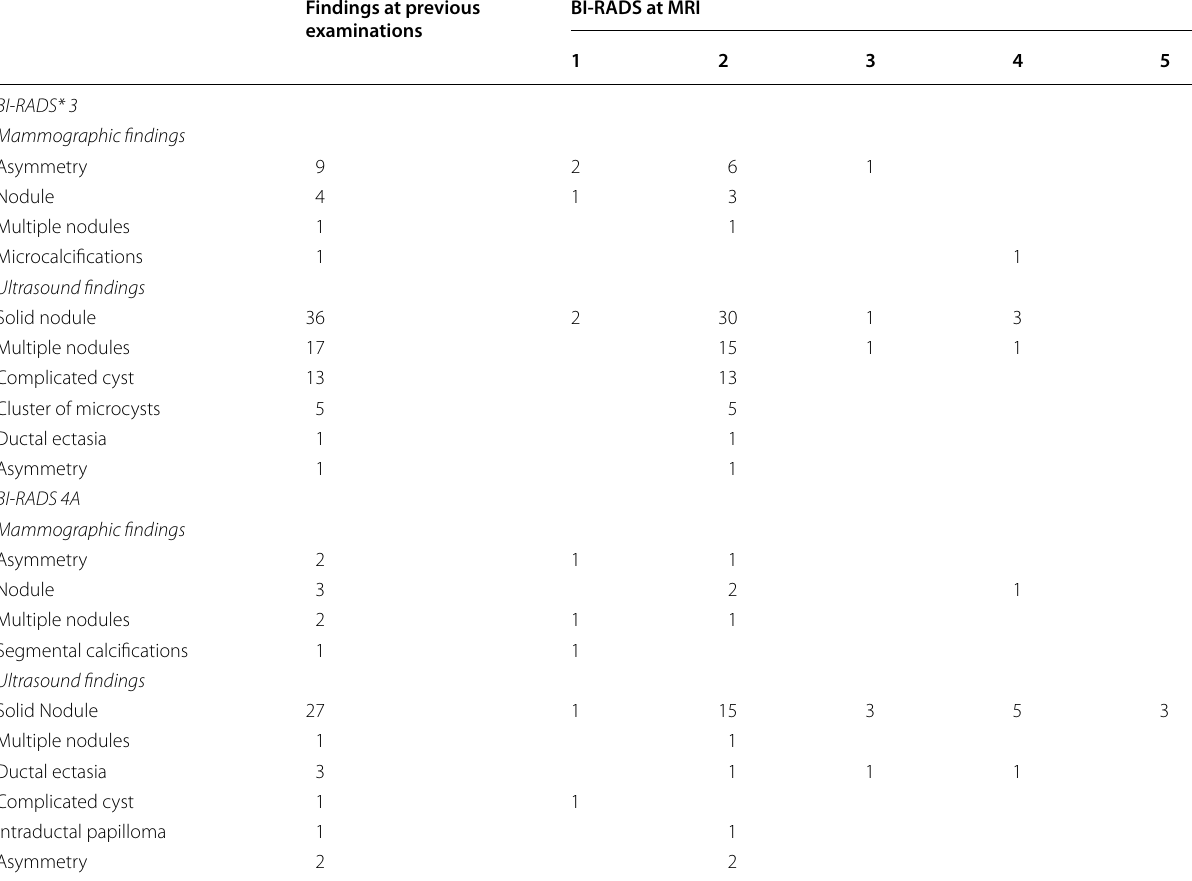
*Breast imaging-reporting and database